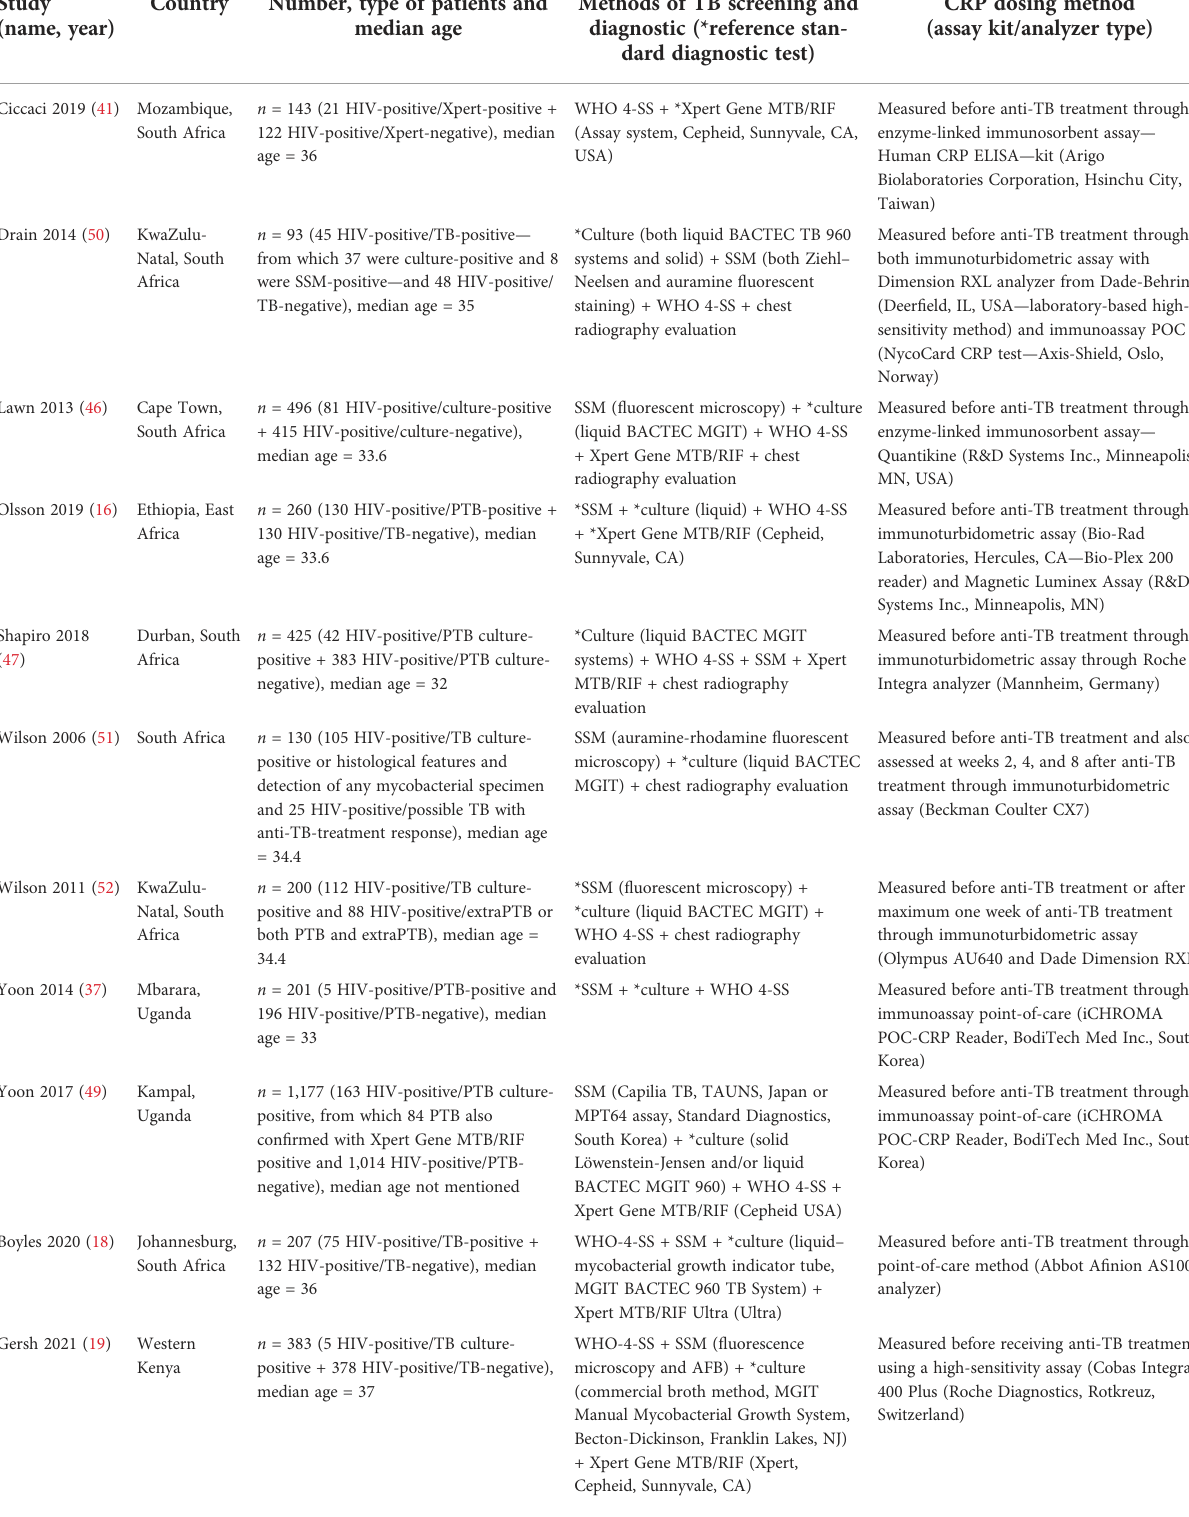
TABLE 1 Characteristics of included